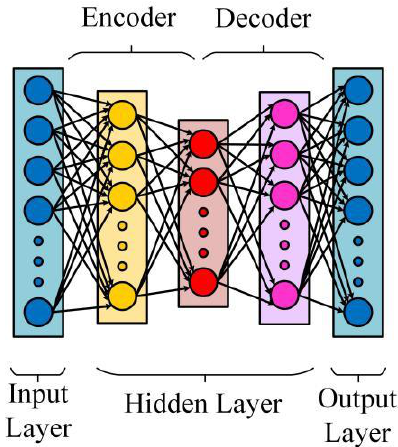
Figure 1. AE Figure 1. AE framework.